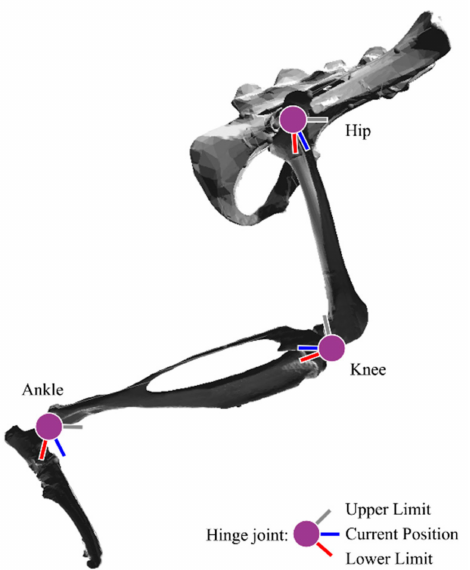
Figure 1. Hindlimb bones segments from Rattus norvegicus . Hinge joints are represented at the hip, knee, and ankle. The absolute joint angle limits are represented by the red and gray bars, while the blue bars represent the current orientation of the distal